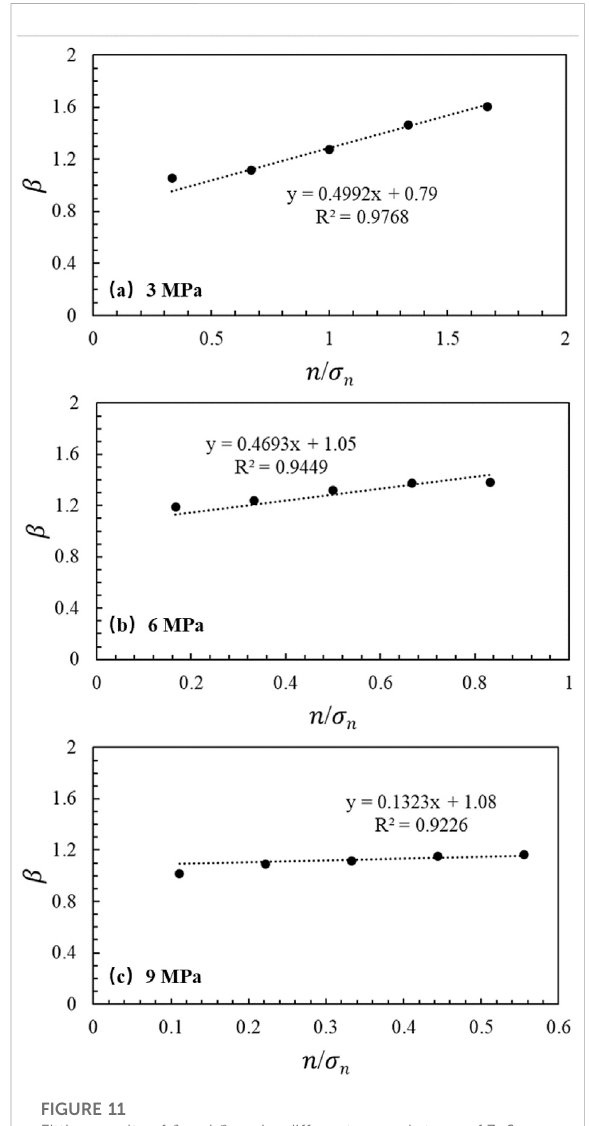
under different normal stress of 3, 6 n